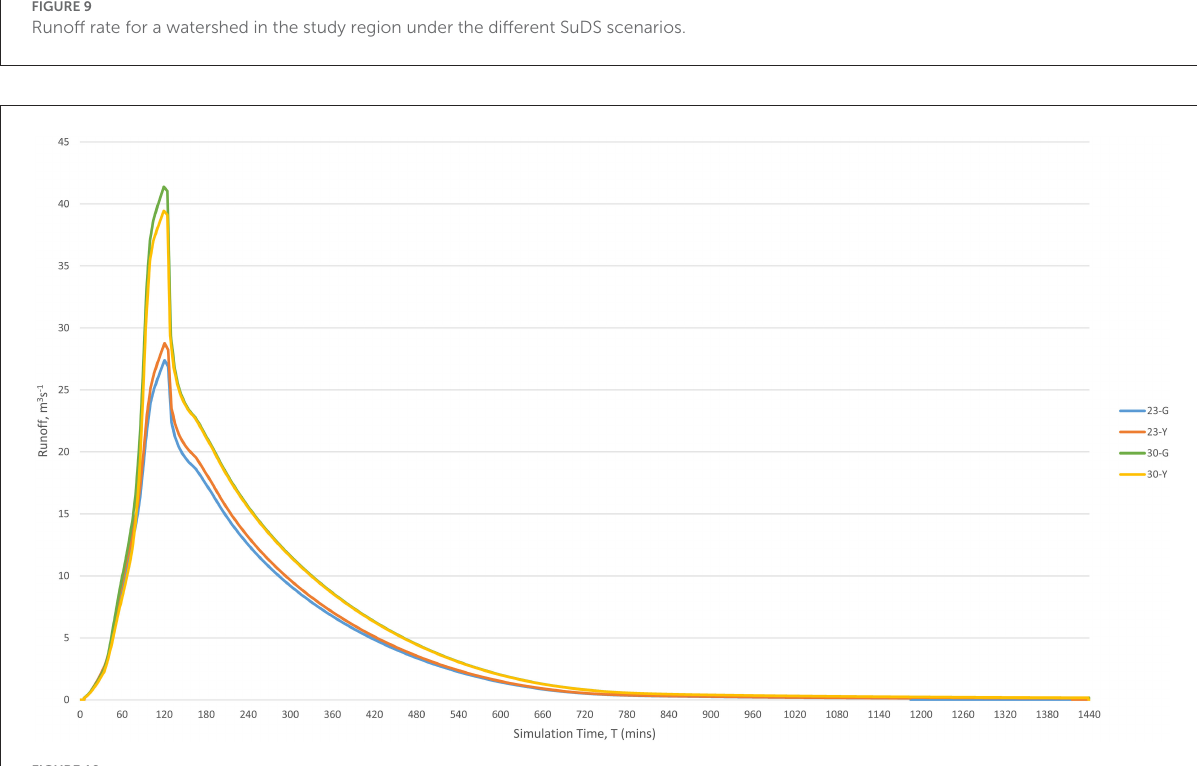
between the two, and thus show little difference in runoff responses. Where this is not the case, the scenario with the